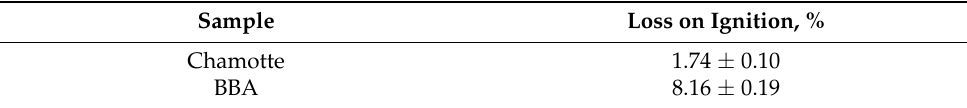
Table 3. Loss on ignition for the chamotte and the BBA.